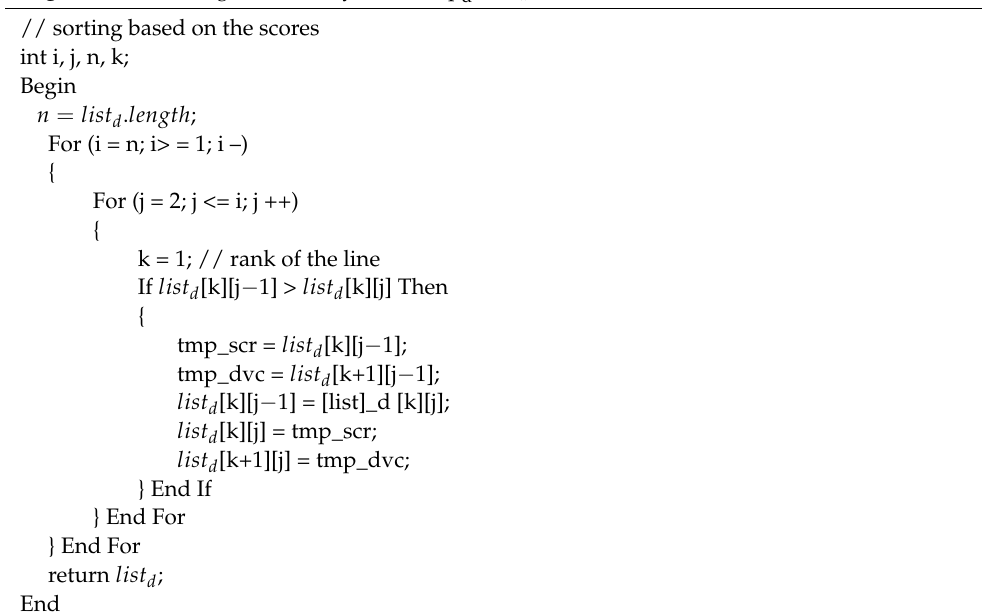
Algorithm 3. Sorting_Devices_By_Scores (ip